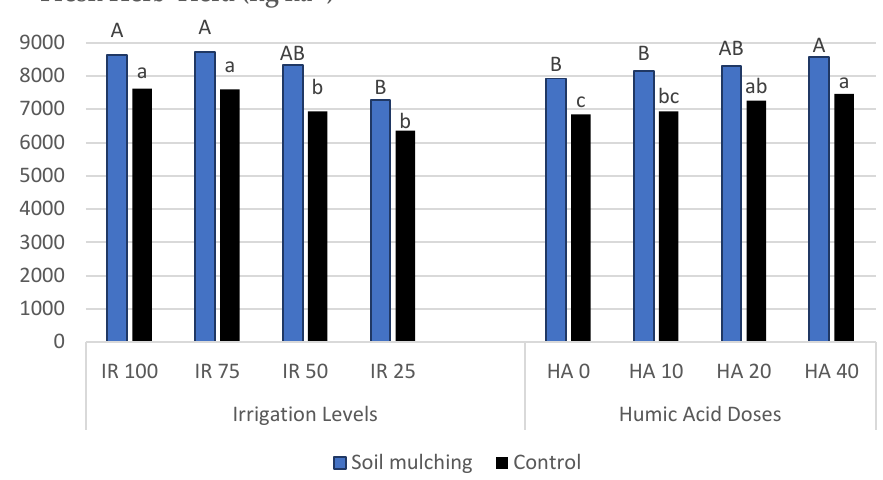
Figure 6. Mean values of FHY of O. basilicum L. under soil mulching and control conditions. IRL 100 = 100% FC; IRL 75 = 75% FC; IRL 50 = 50% FC; IRL 25 = 25% FC; HA 0 = 0.0 Lha − 1 ; HA 10 = 10.0 Lha − 1 ; HA 20 = 20.0 Lha − 1 ; HA 40 = 40.0 Lha − 1 .